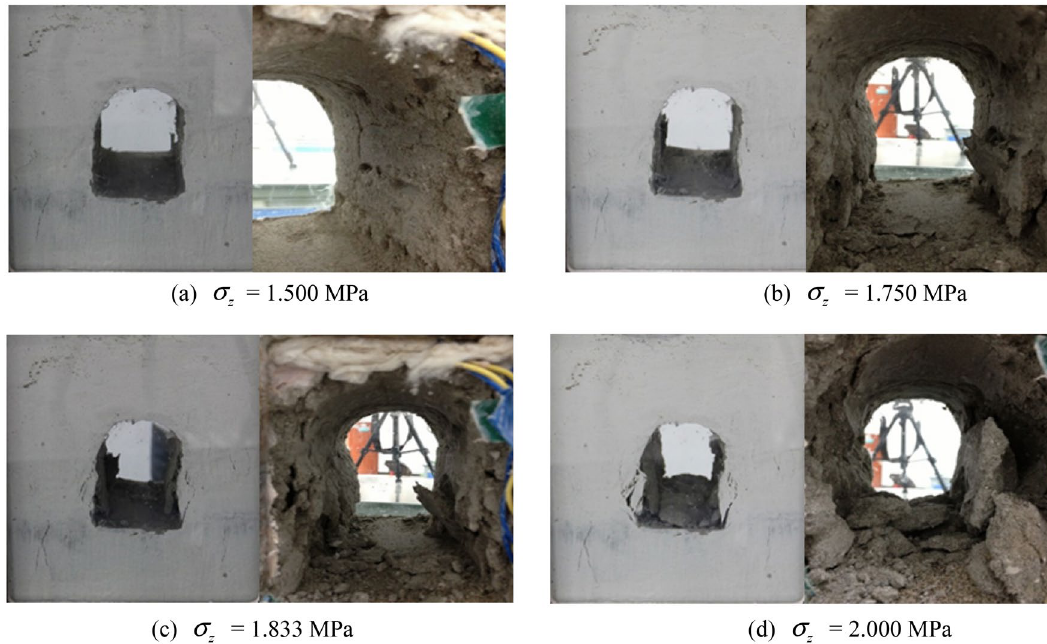
Figure 12. Fracture propagation during excavation unloading with surrounding rock stresses of 100% σ zmax .